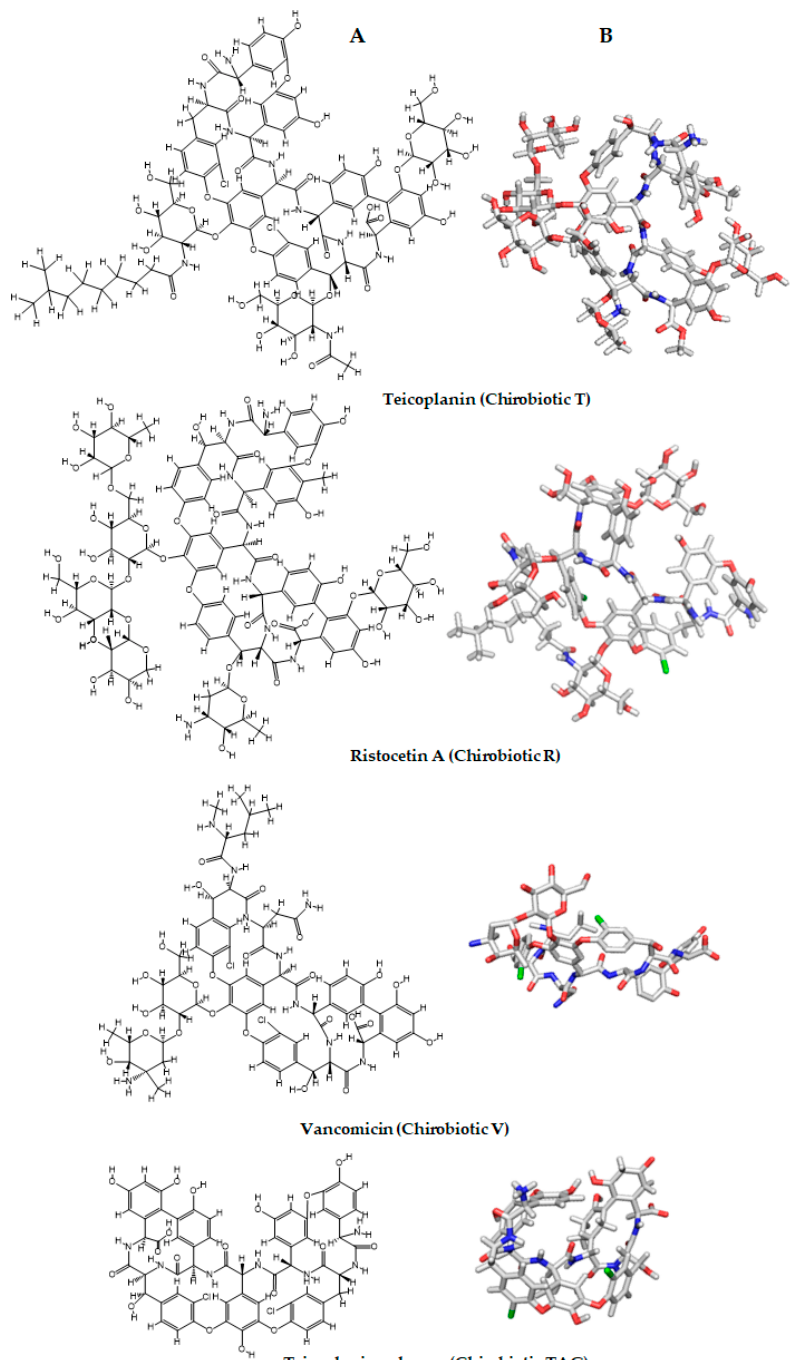
Figure 1. 2D ( A ) and 3D ( B ) structures of the four macrocyclic glycopeptide-based selectors. Chiral selectors are represented in sticks with C, O, N, and Cl atoms colored in grey, red, blue and green, respectively.